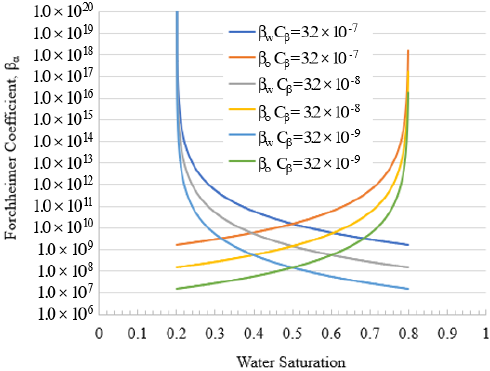
Figure 4. Forchheimer coefficient curves.